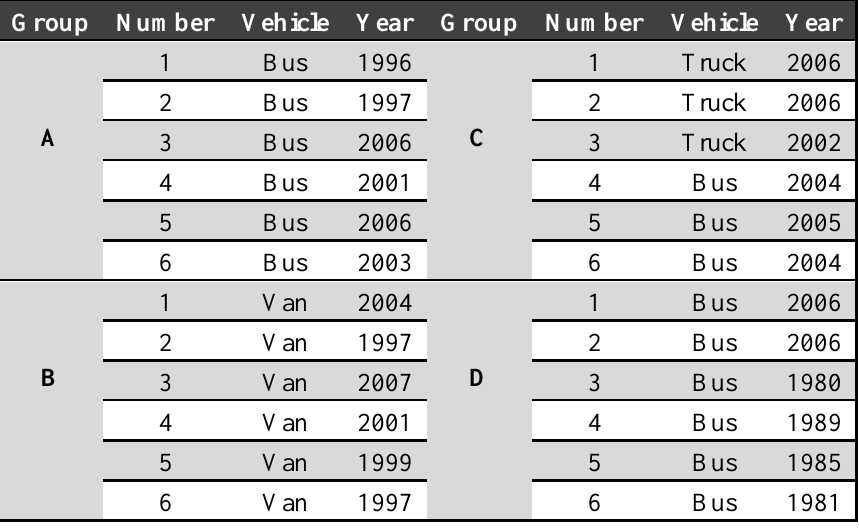
Figure 4. Ethylene gas concentration [ppmV].